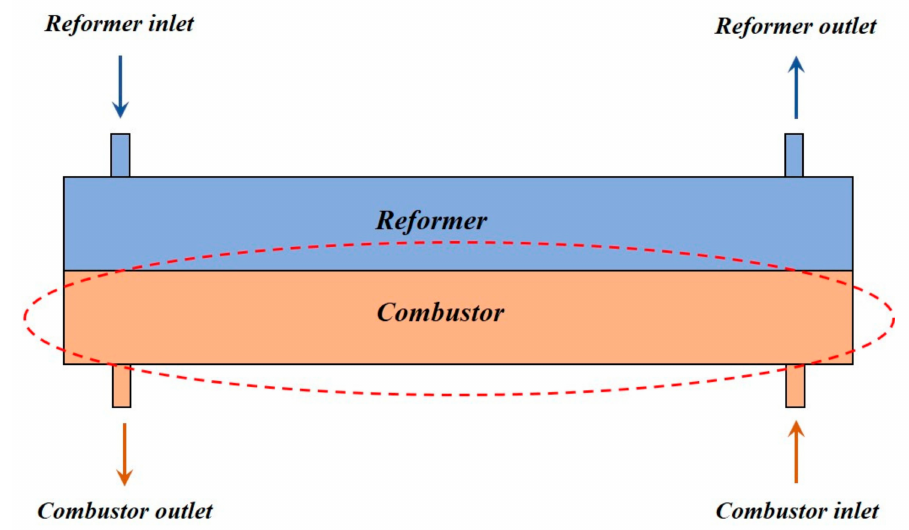
Figure 2. A 2D representation of an integrated combustion–reformer setup used in the experimental setup of reference [5]. The domain selected for the present model is encircled in